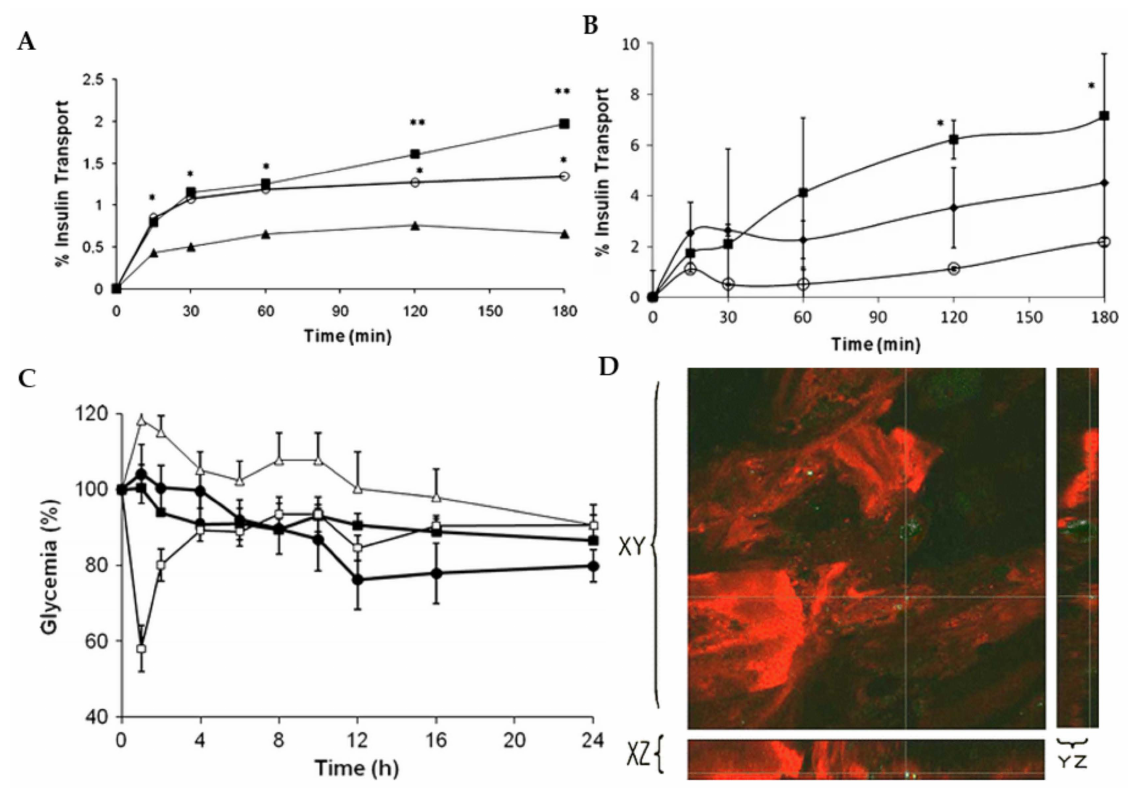
Figure 6. ( A ) Cumulative permeation of insulin through Caco-2 loaded into SLN (circles) and chitosan-coated SLN (squares) comparatively to free insulin (triangles). * p < 0.05, SLN and chitosan- coated SLN are statistically different from free insulin. ** p < 0.05 chitosan-coated SLN are statistically different from SLN; ( B ) Cumulative permeation of insulin through Caco-2/HT29 co-culture mono- layer loaded into SLN (diamonds) and chitosan-coated SLN (squares) comparatively to free insulin (circles). * p chitosan-coated SLN are statistically different from free insulin. ( C ) Reduction of plasma glucose concentration upon subcutaneous delivery of insulin 2.5 IU/kg (empty squares), oral delivery of insulin 25 IU/kg (triangles), SLN loading insulin 25 IU/kg (filled squares), and chitosan-coated SLN loading insulin 25 IU/kg (circle) ( n = 6). ( D ) Green fluorescence of labelled insulin loaded into chitosan-coated SLN in an inner apical intestinal section of a